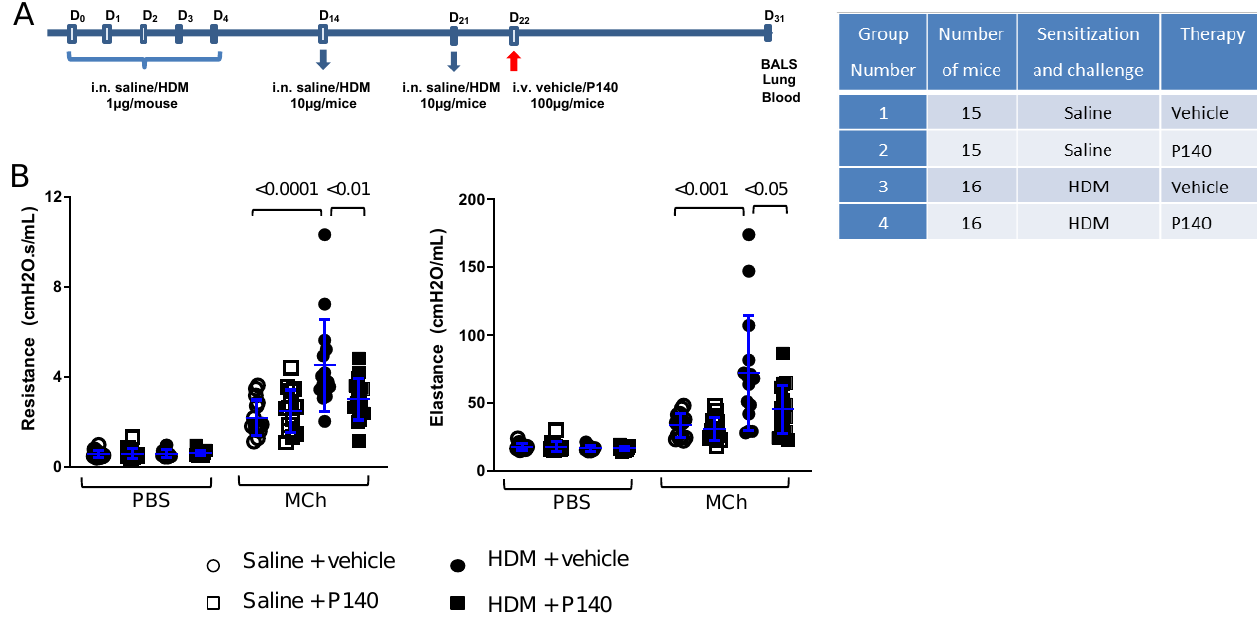
Figure 2. The effect of the P140 peptide in a chronic model of HDM-induced airway inflammation in BALB/c